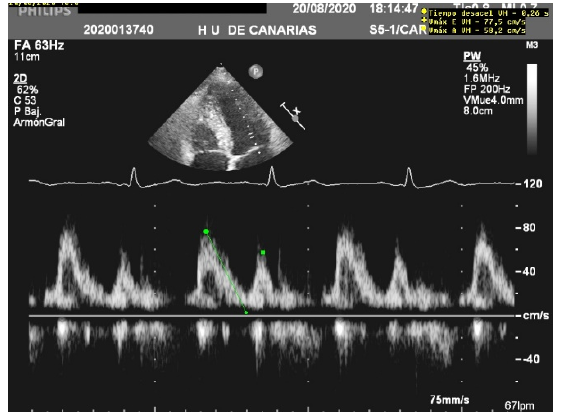
Figure 1. E wave height, deceleration time, and A wave. Normal filling pattern.